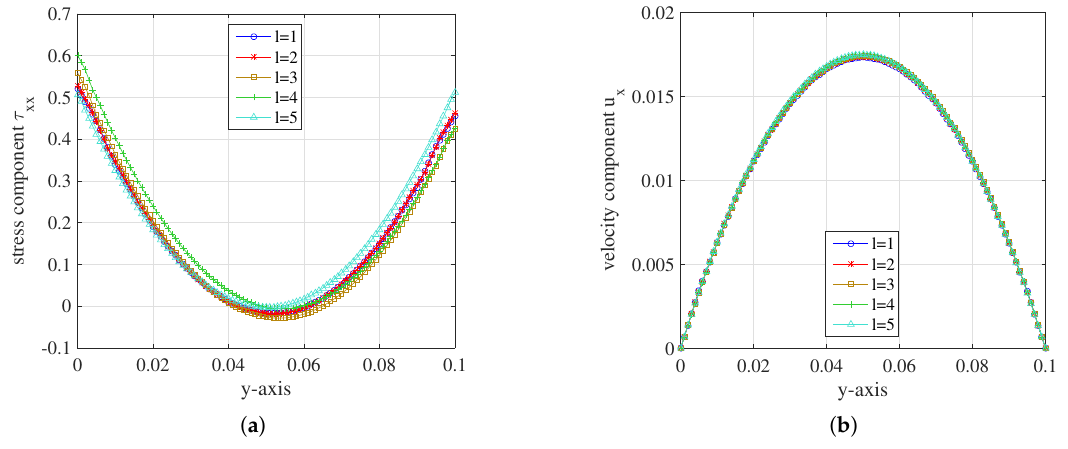
Figure 11. ( a ) Stress component τ xx ; and ( b ) velocity component u x on the y -axis during the steady state at t = 1.999185 for different mesh levels of FENE